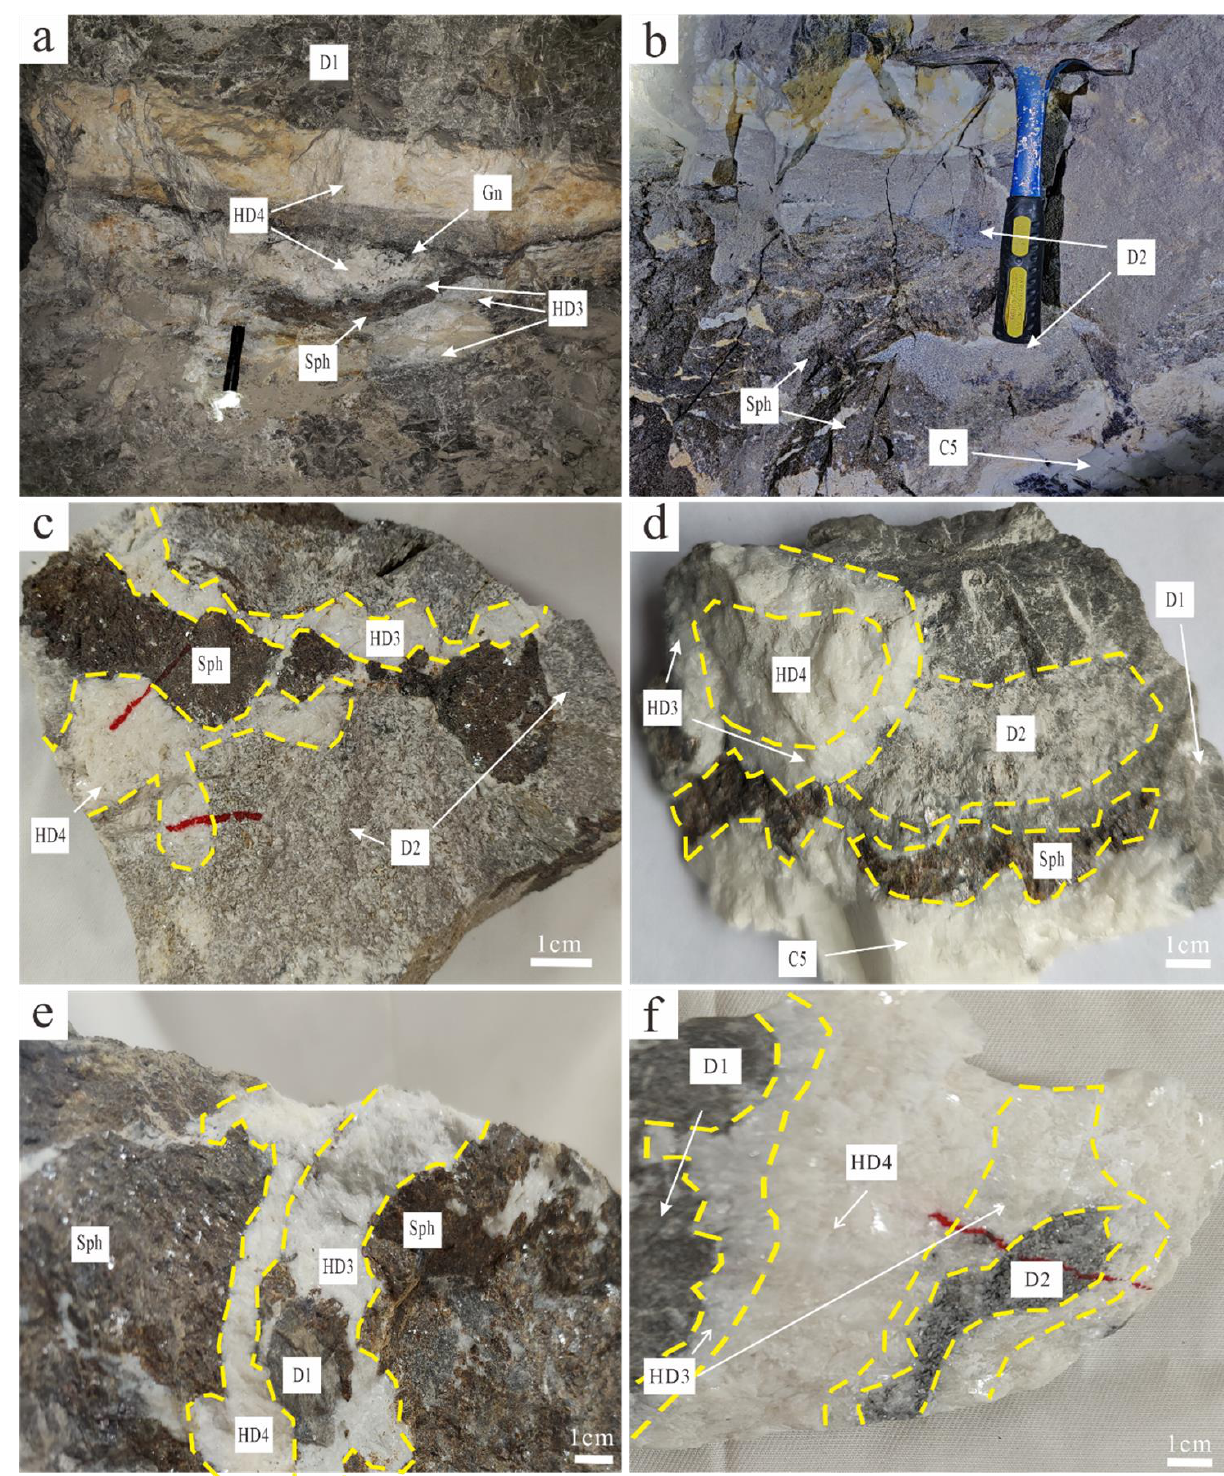
Figure 3. Photographs of samples from the Fuli Pb-Zn deposit. ( a , b ) Massive Sp and/or Gn are filled/cemented by Dol/Cal veins. ( c ) D2 altered dolostone disseminated by sphalerite and galena and HD3 grey dolomite coexisting with sphalerite and galena. ( d ) Hydrothermal dolomite cement host rock and sphalerite clasts, both cut by late calcite. ( e ) Dark and red-brown sphalerite and HD3 grey dolomite crosscut by HD4 white dolomite. ( f ) HD4 white dolomite replacing HD3 grey dolomite.